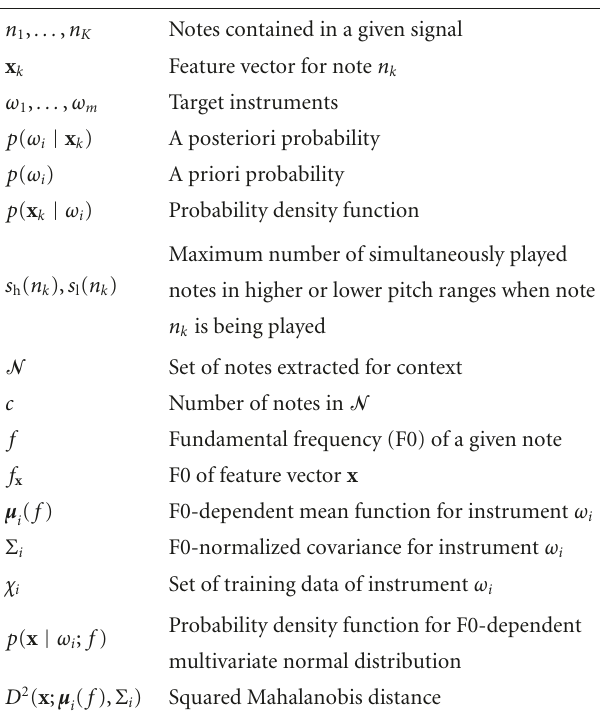
Table 1: List of